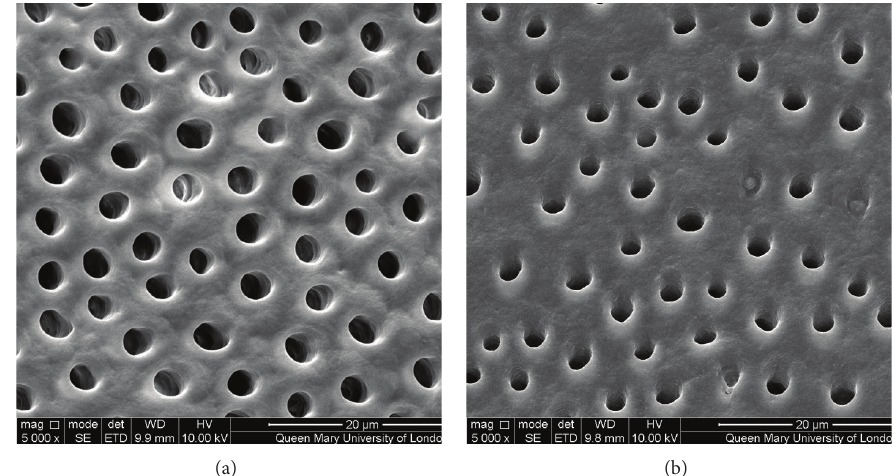
Figure 4: SEM images of dentine tubules treated with a 1.4% potassium oxalate oral rinse (LISTERINE Advanced Defence Sensitive Mouthwash), before treatment (a) and after treatment